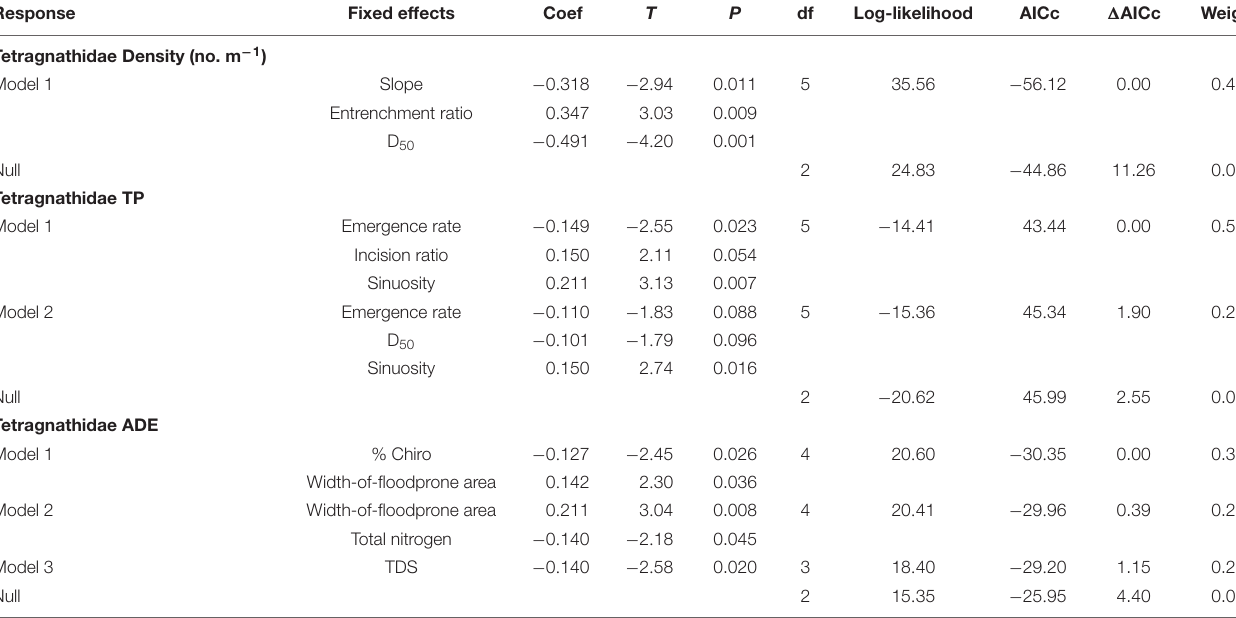
TABLE 3 | Model results with AICc < 2 (excluding those with uninformative parameters) from generalized linear models (using lognormal distributions) for tetragnathid spider characteristics with hydrogeomorphic, emergent aquatic insect, riparian vegetation, and chemical water-quality characteristics as predictor variables. Response Fixed effects Coef T P df Log-likelihood